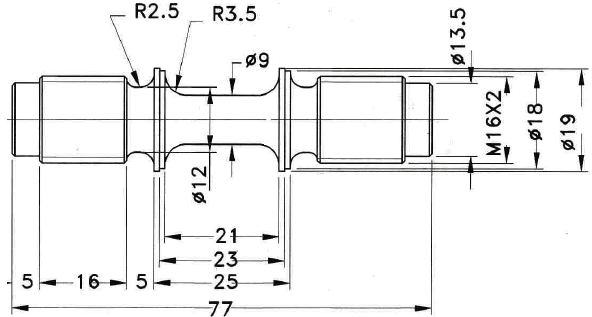
Figure 1. Dimension of Specimen used for In-Sodium LCF Test (all dimensions are in mm).